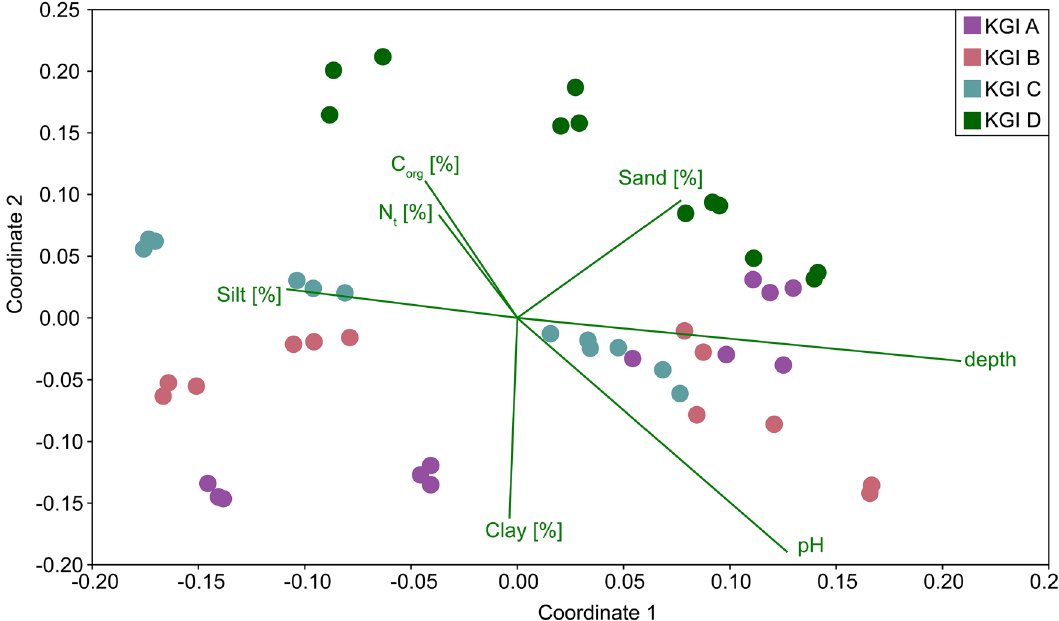
Figure 5. Non-metric multidimensional scaling plot comparing the microbial communities of three soil profiles in the foreland and one soil profile distal to the lateral moraine of the Ecology Glacier, King George Island, based on the Bray–Curtis dissimilarity. Environmental parameters were standardized using z-scores. The stress value was